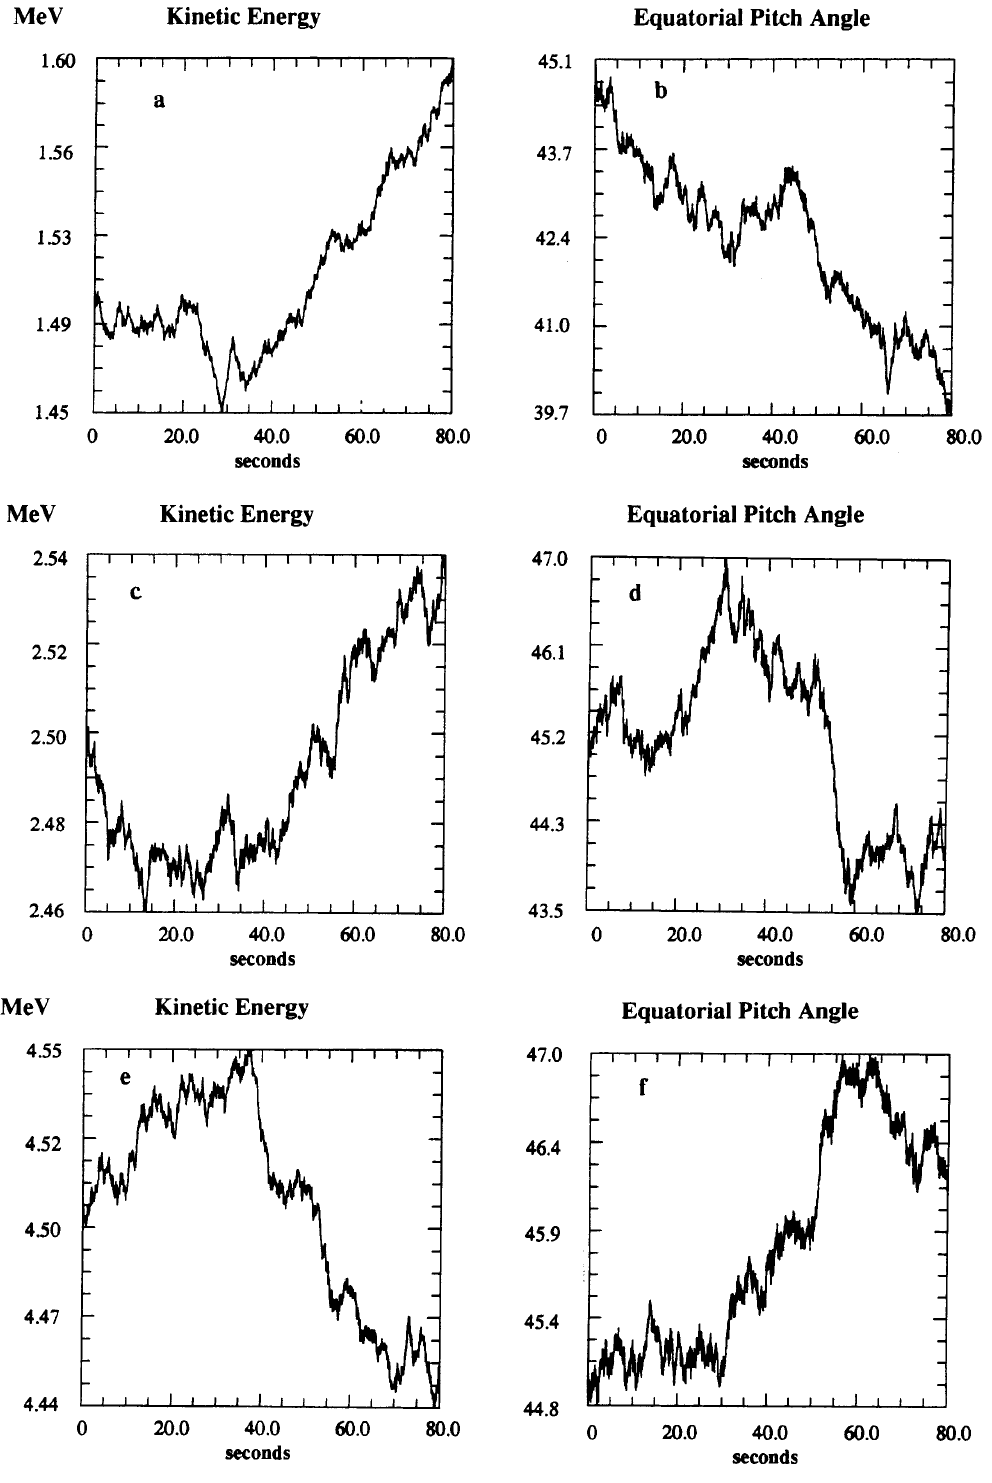
Fig. 2. Kinetic energy (W) and equatorial pitch angle ( a ) vs time for the three sample particles. W = 1.5, 2.5, 4.5 MeV; a = 45